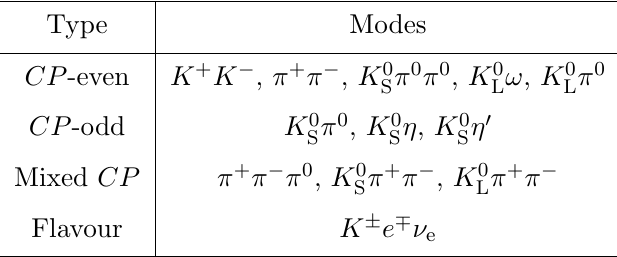
Table 1 . Di(cid:11)erent tag modes used in the